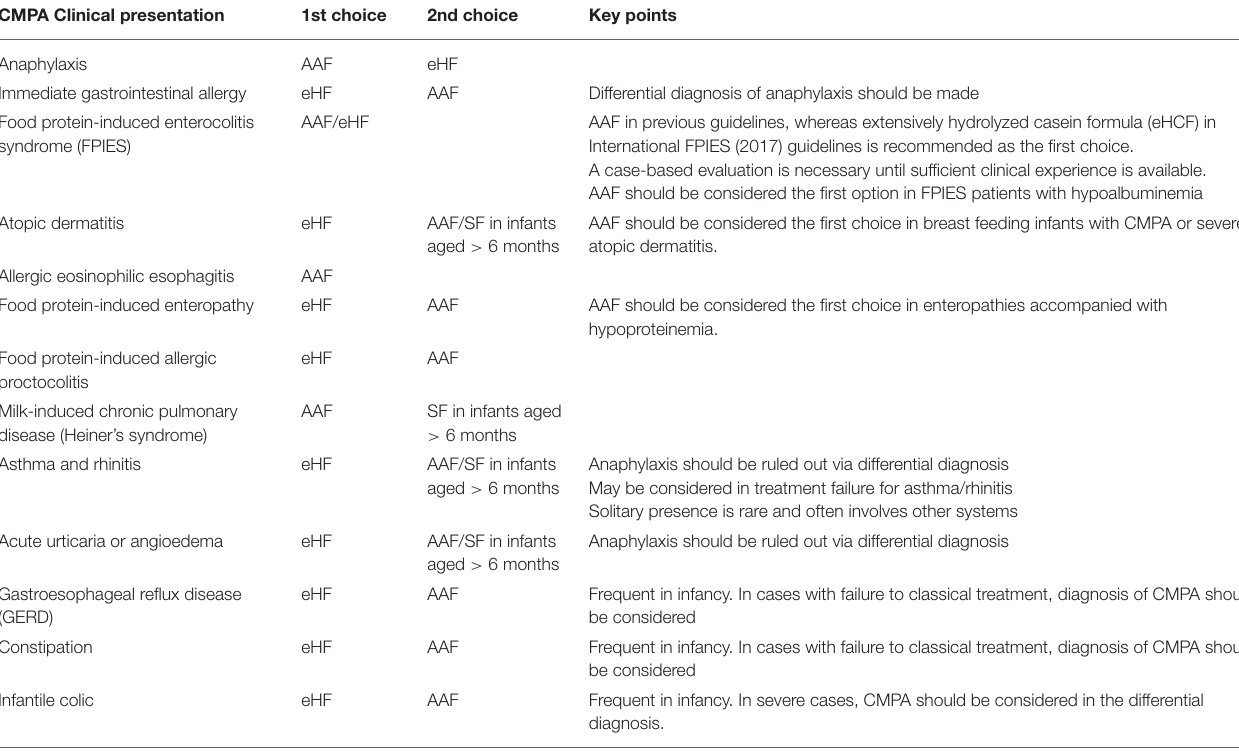
TABLE 2 | Choice of formula in non–breast-fed infants with confirmed CMPA according to clinical presentation (14, 17, 52, 61). CMPA Clinical